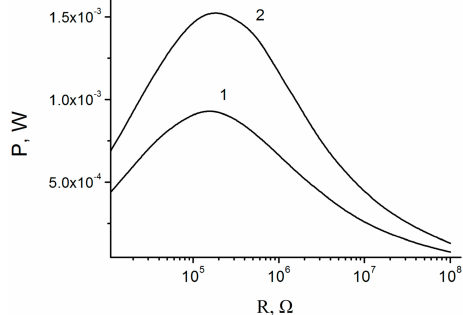
Figure 5. Load curves of the impact generator. d 1 = d 0 = 17 μm, k = 2 × 10 5 N/m, k 0 = 2 × 10 3 N/m, a 0 = 50 m/s 2 , f = 200 Hz, S = 1 cm 2 . V P = 225 V ( 1 ), 293 V ( 2 ).